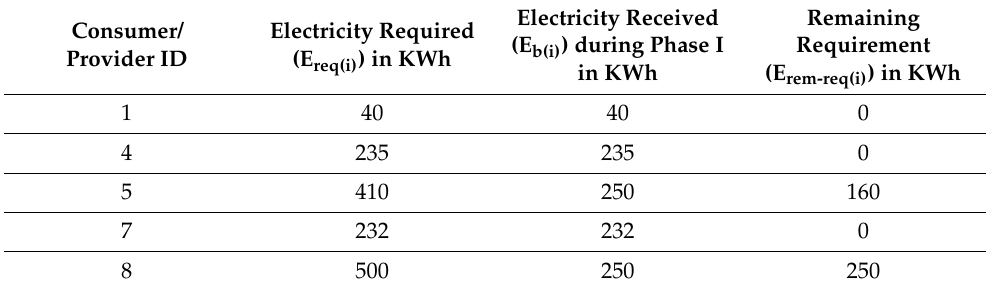
Table 4. Energy scheduling in phase